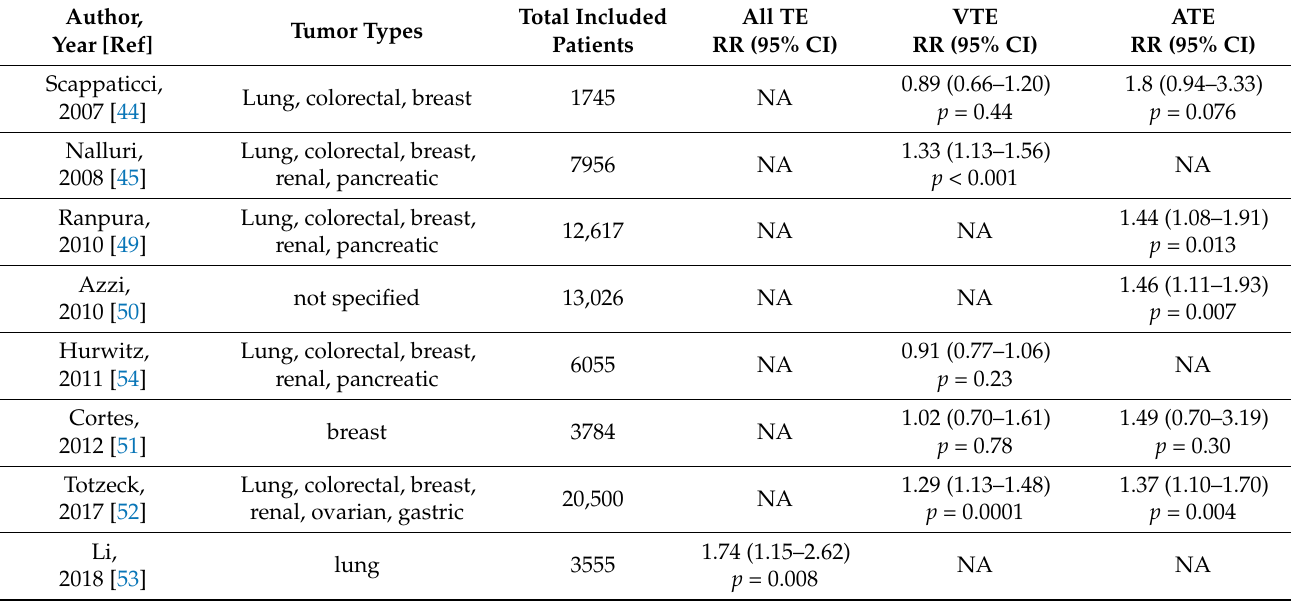
Table 3. Previous meta-analyses on the thromboembolic risk with bevacizumab in various tumor types.